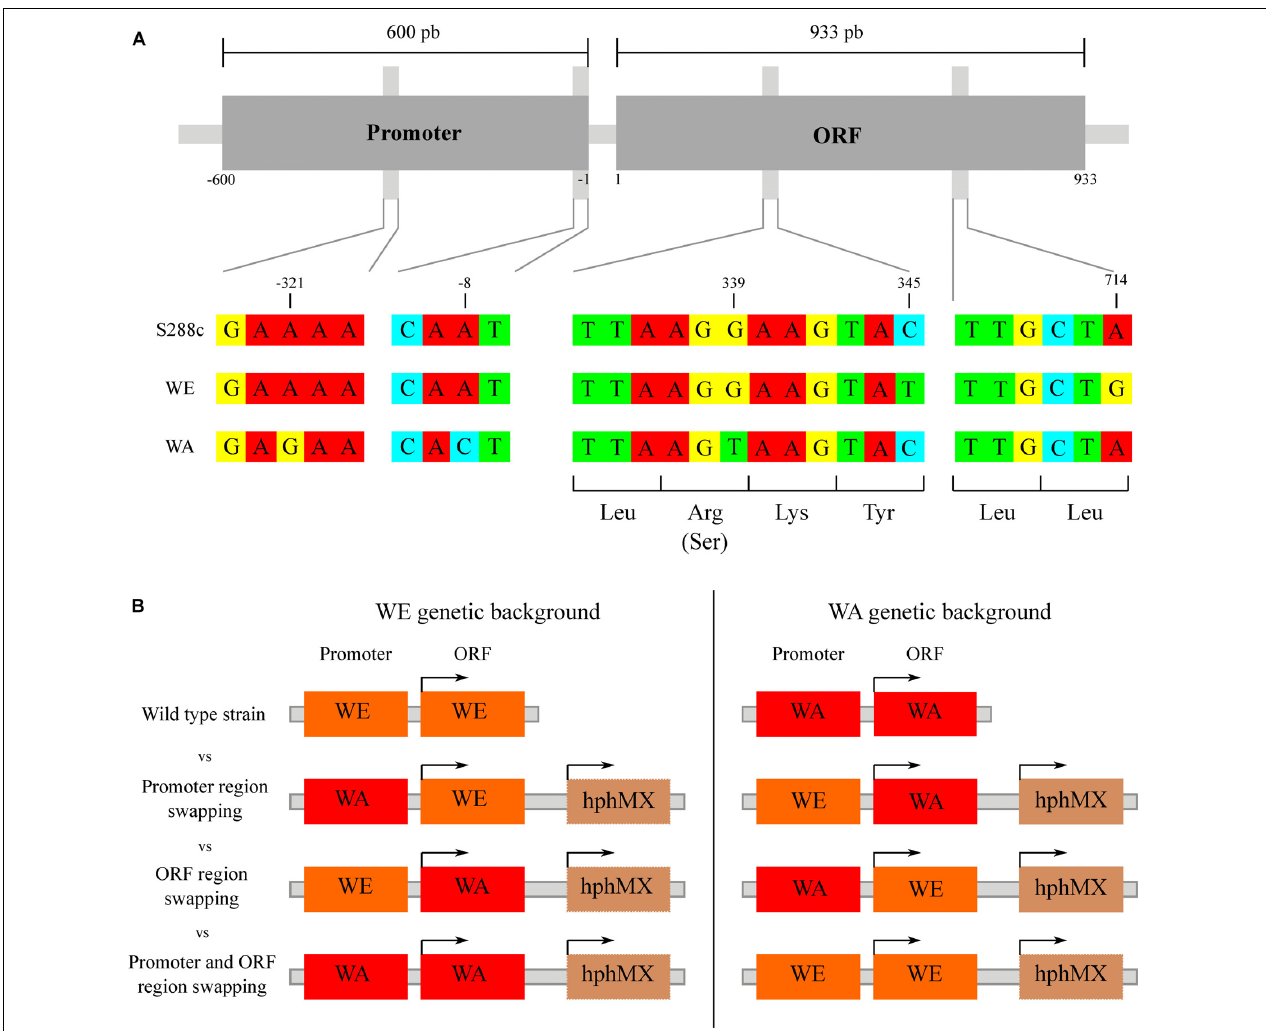
FIGURE 3 | Nucleotide sequence variation for GTR1 gene. (A) Alignment of the promoter and coding regions of the GTR1 gene. The nucleotide sequence of S288c (reference), WE and WA strains were downloaded from the SGRP BLAST server of the University of Toronto (http://www.moseslab.csb.utoronto.ca/sgrp/) and aligned using MUSCLE (http://www.ebi.ac.uk/Tools/msa/muscle/). (B) Scheme of the swap strategy for promoter region, ORF region or both regions. Each promoter and/or ORF was swapped in the opposite genetic background, generating three different combinations. The strain background is shown as an orange (WE) or red (WA)